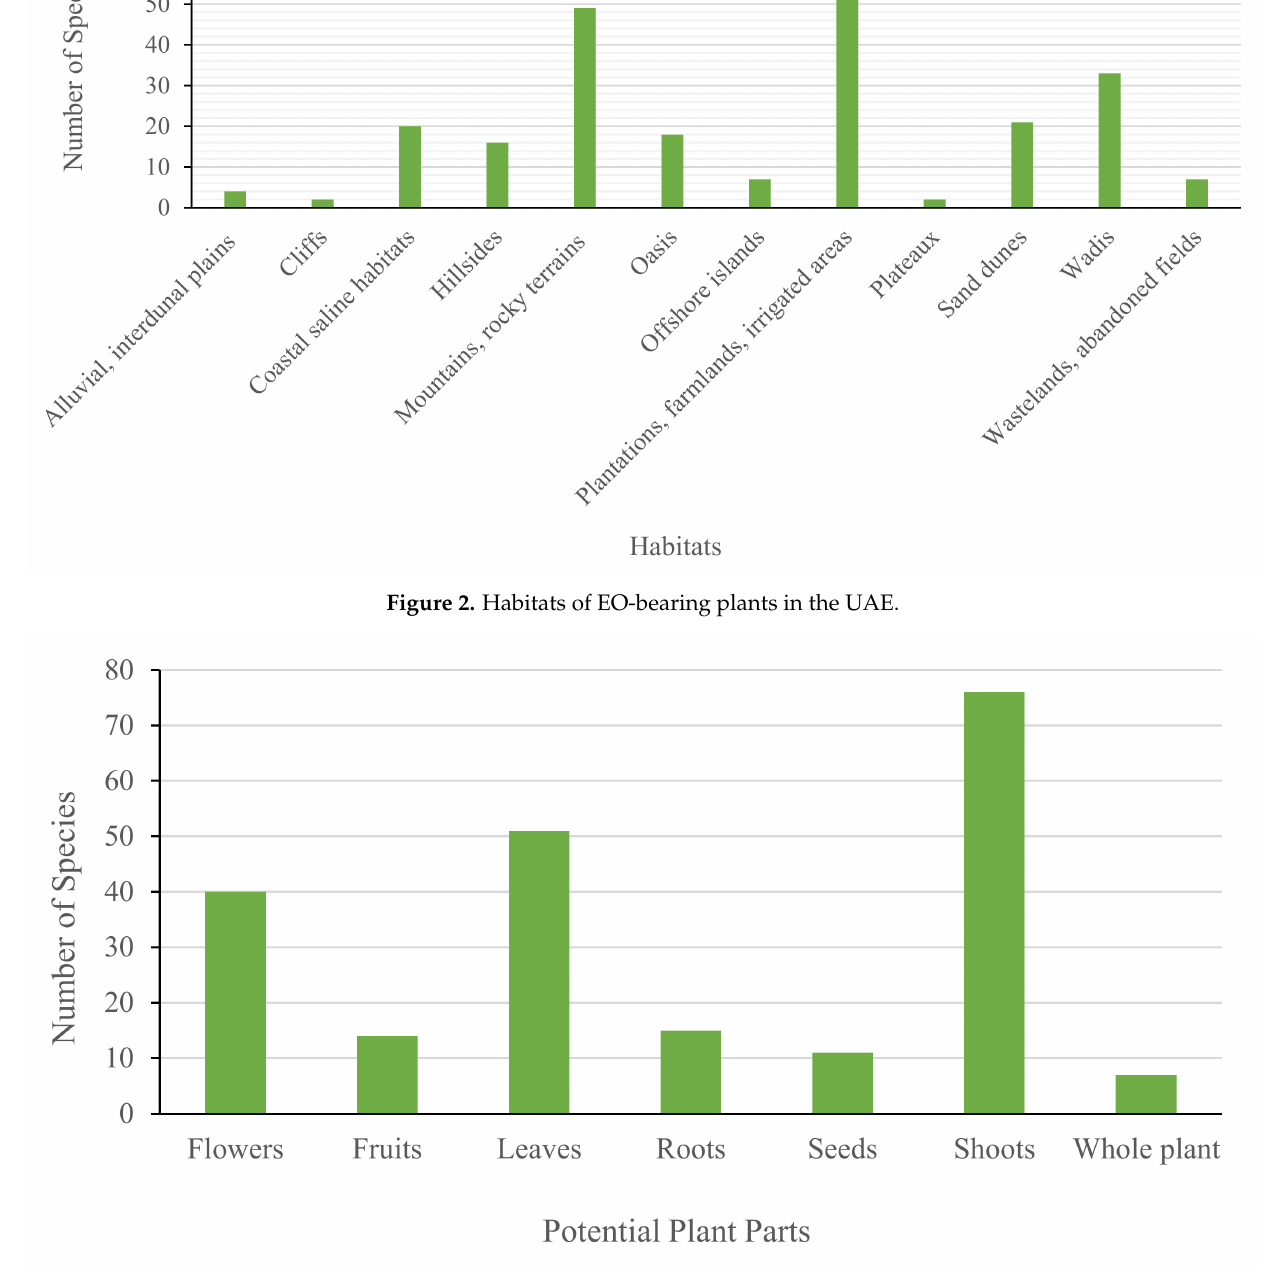
Figure 3. Major plant parts for EO production in the